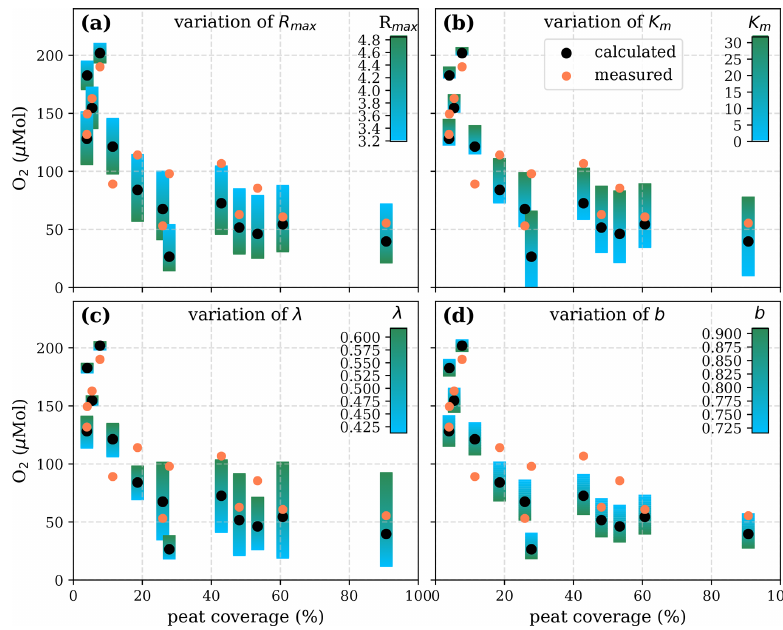
Figure A7. Sensitivity of calculated O 2 to (a) the maximum decomposition rate ( R max ), (b) the Michaelis constant for O 2 concentration ( K m ), (c) the exponential pH limitation constant ( λ ), and (d) the fraction of O 2 consumption by decomposition according to the equation in Table 2 for the exponential pH approach and the parameter ranges given in Table 5.